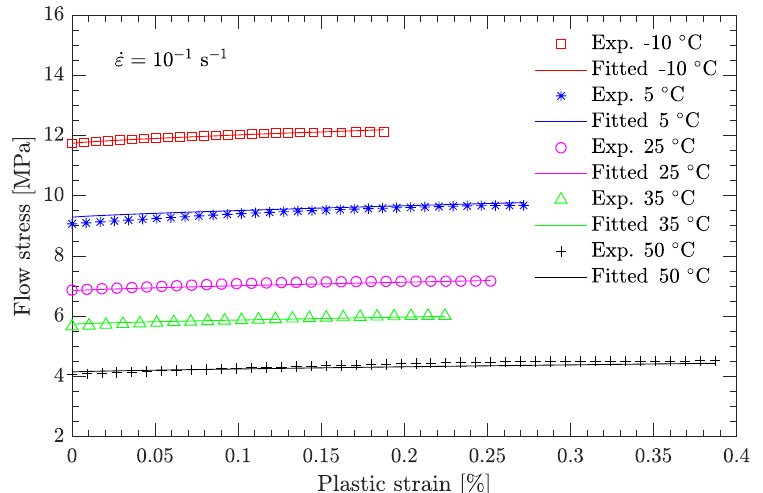
Figure 10. Comparison of fitted and measured flow stresses at a strain rate of 10 − 1 s − 1 .